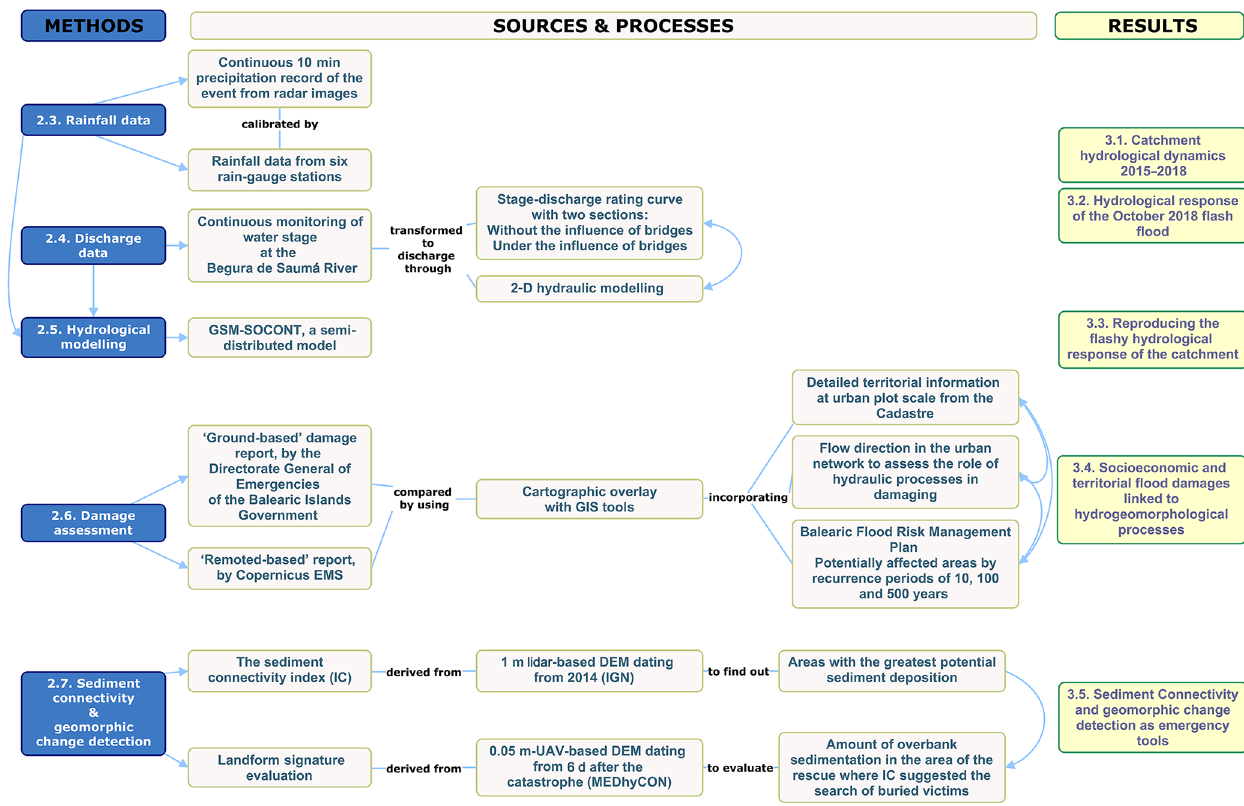
Figure 1. Workflow of the experimental